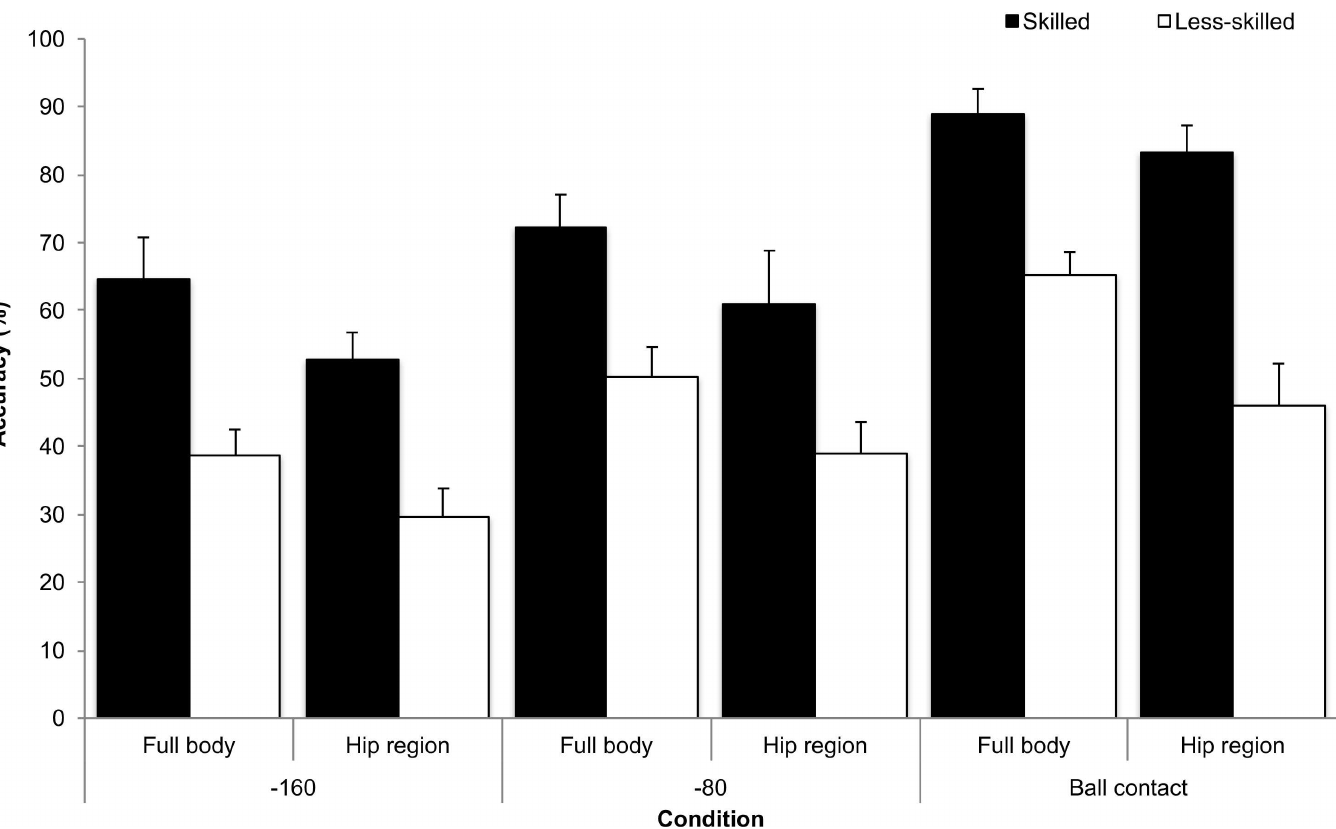
Fig 2. Correctresponse (%; SD) for the skilled and less-skilled groups in the full body and hip region spatial occlusion conditions and for the -160, -80 and ball contact temporal occlusion conditions.